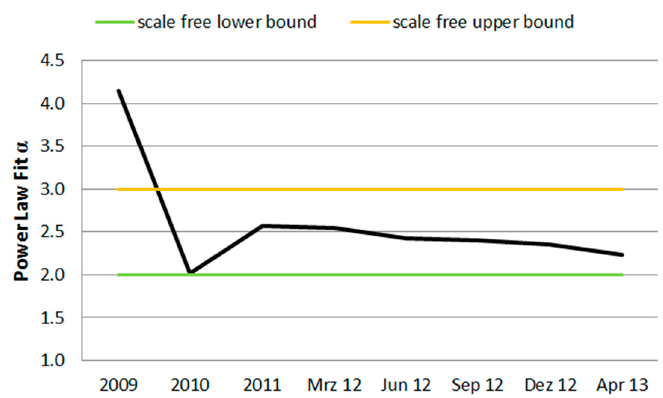
Figure 22. Development of Power Law Fit α over Time.